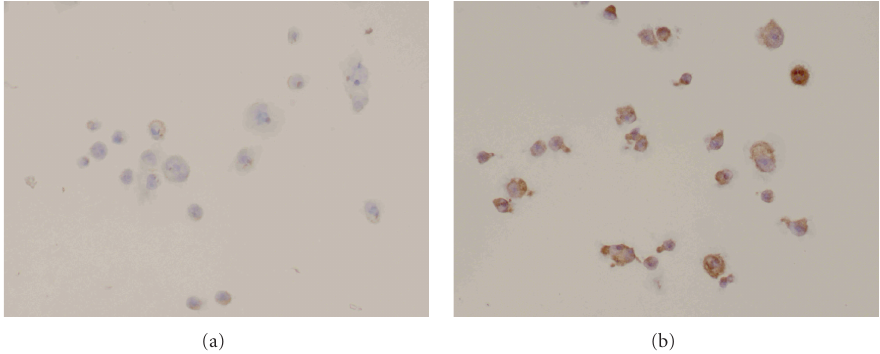
Figure 7: ICC for BCL2 in untreated (a) and E. tirucalli -treated cells (b). Magnification 40x.